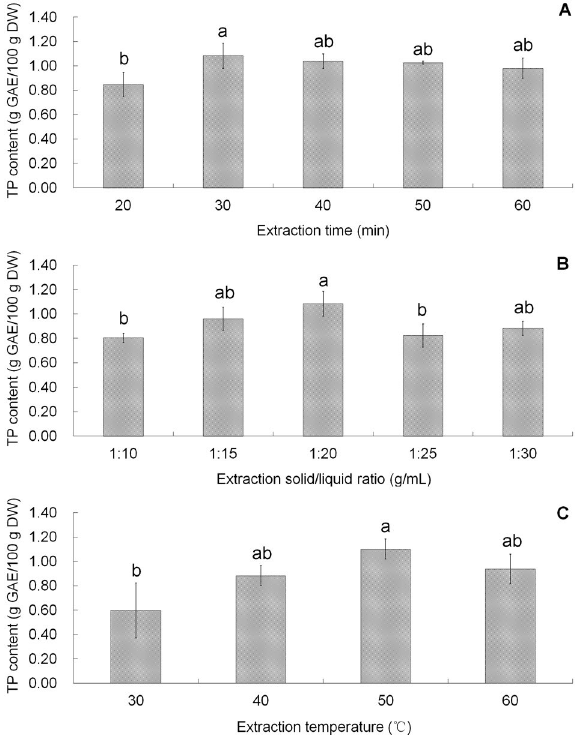
Figure 2. Effect of single factors ( A ) extraction time, ( B ) solid/liquid ratio, and ( C ) temperature on TP content. Means of each two treatments were compared using least significant difference (LSD) statistic method. Lowercase letters a and b were used to mark significance of difference ( p < 0.05). Same letters between treatments mean insignificant difference. Different letters between treatments mean significant